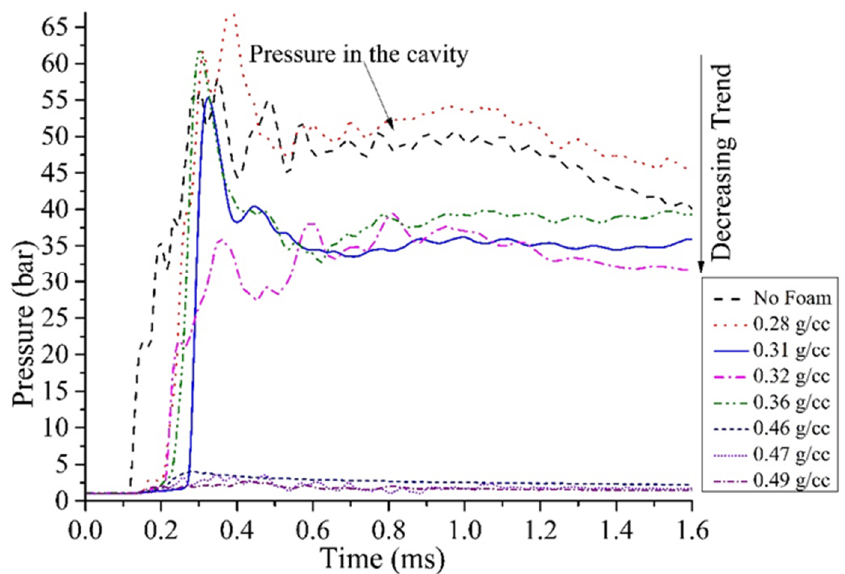
Figure 6. Variation of transmitted wave pressure with time in the air cavity (sensor-2) in the presence of various density foams and, without any foam (baseline).